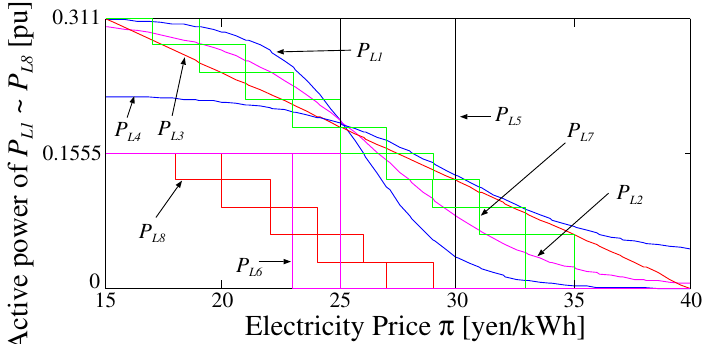
Figure 12. Power consumption of each controllable load for electricity price (Load 4, 6).